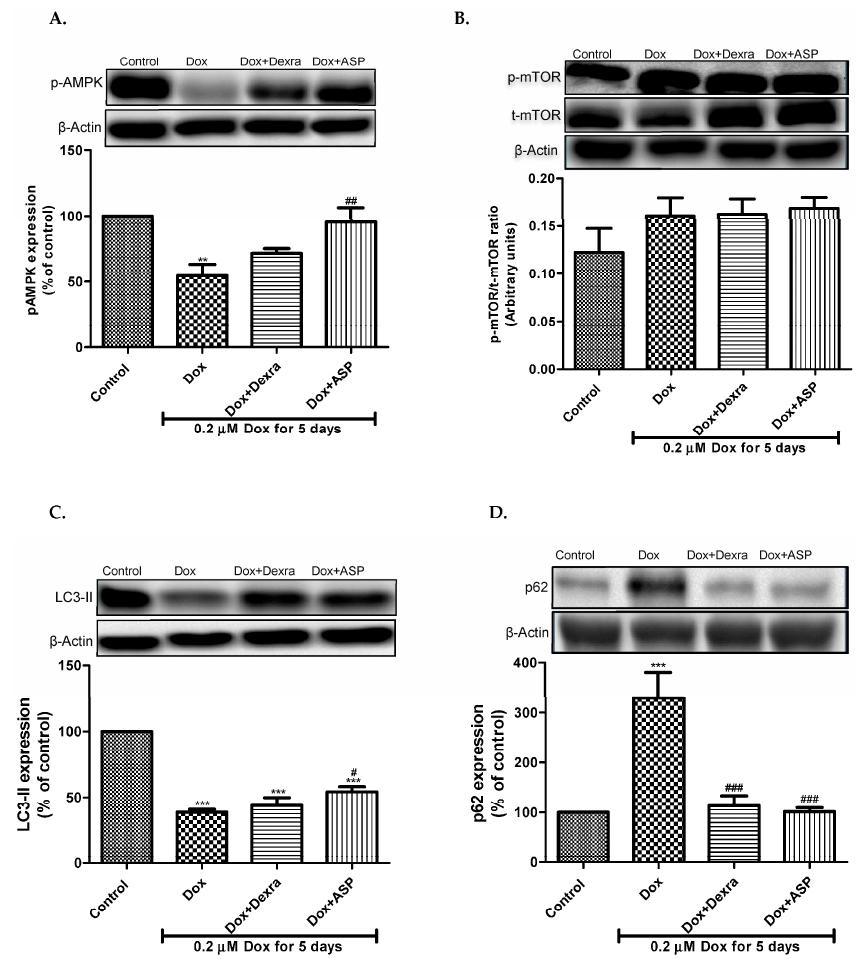
Figure 2. The effect of aspalathin on autophagy proteins. ( A ) Represents the expression of phosphor (p)adenosine monophosphate-activated protein kinase (AMPK) ; ( B ) the expression of mammalian target of rapamycin (mTOR); ( C ) the expression of LC3-II; and ( D ) the expression of p62 in doxorubicin (Dox)-induced cardiotoxicity. H9c2 cells were treated with 0.2 µM Dox alone or in combination with either 20 µM dexrazoxane (Dexra) or 0.2 µM ASP daily for 5 days. Control samples were exposed to media only. All blots were normalized to beta actin. Results are expressed as the mean ± SEM of three independent biological experiments, each with three technical replicates ( n = 9). ** p *** p ≤ 0.01 versus control and # p ≤ 0.05, ## p ≤ 0.01 and ### p ≤ 0.01 versus Dox.